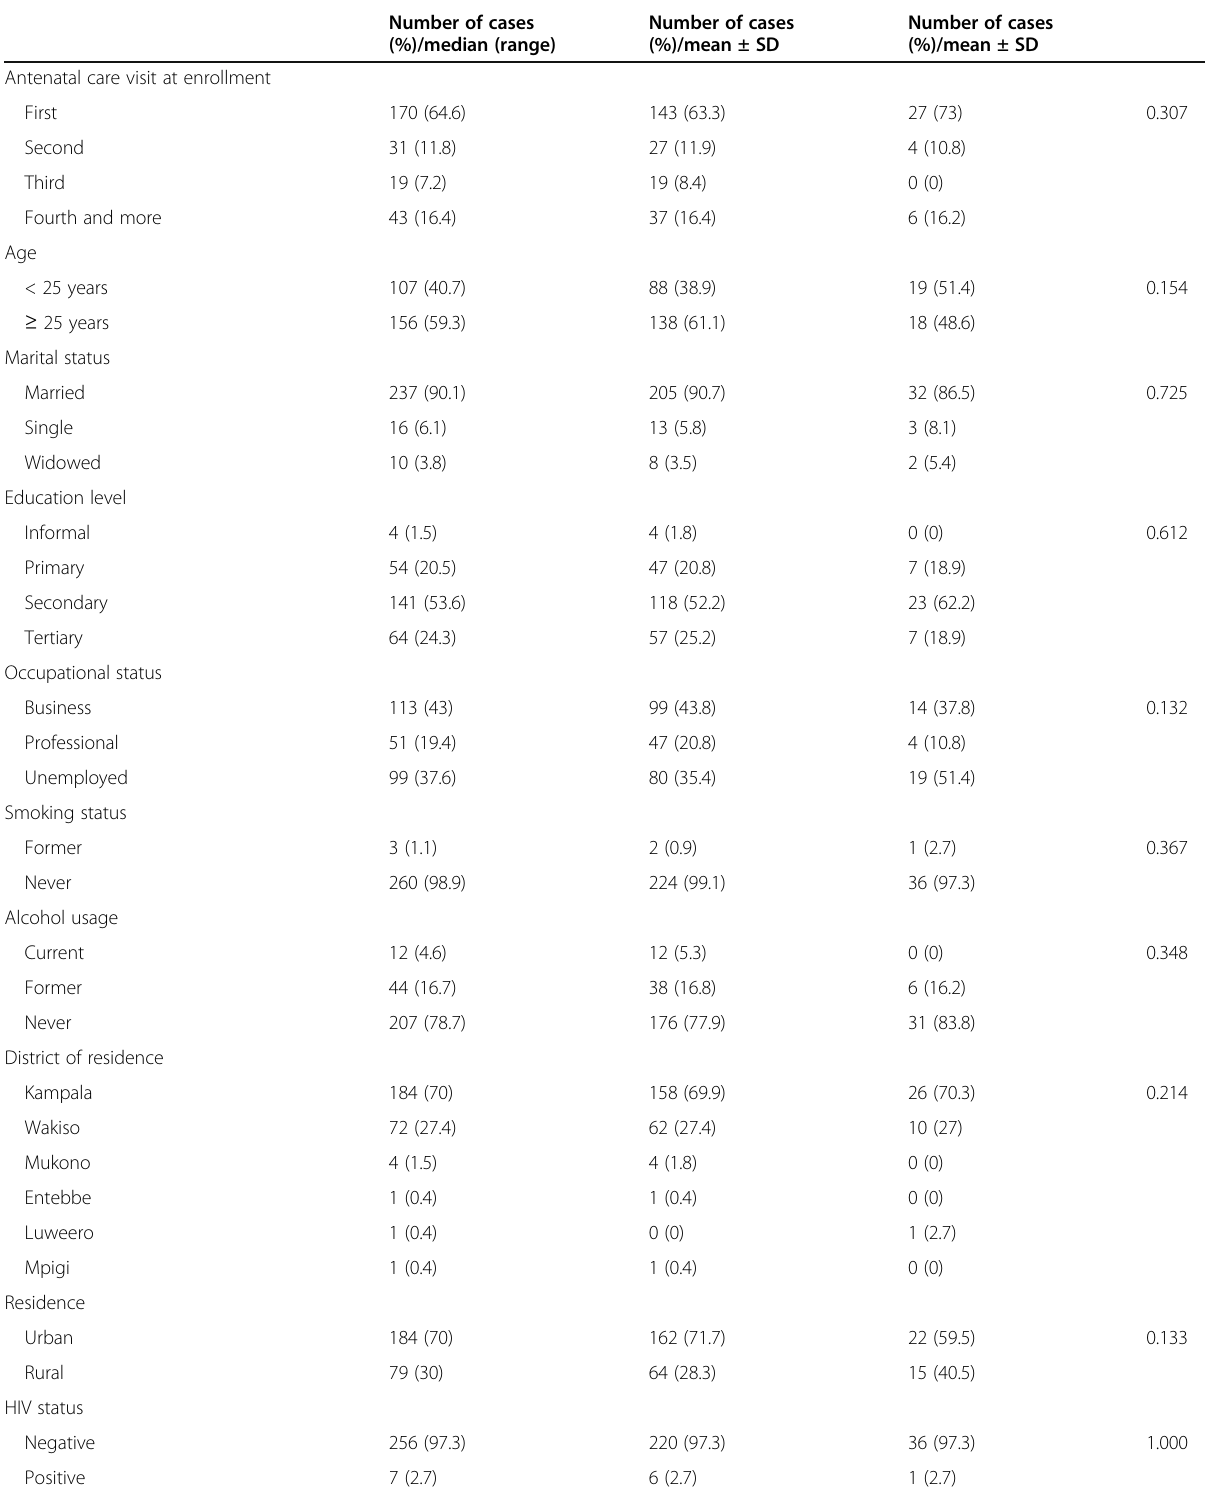
Table 1 Bivariate analysis for socio-demographic and anthropometric factors associated with anemia in